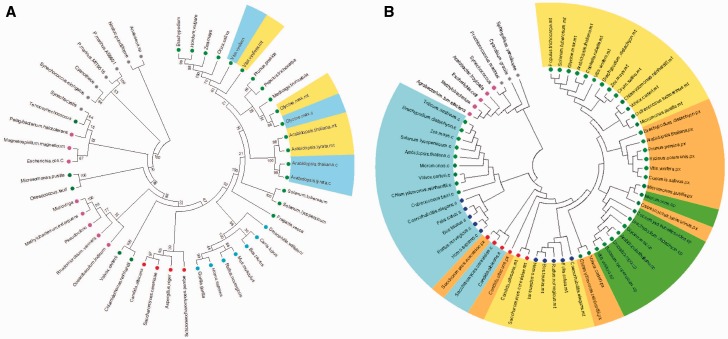
The phylogenetic tree of (A) fumarase and (B) MDH. Trees were built using putative amino acids sequences from (A) fumarase and (B) MDH. Subcellular compartments are highlighted as in figure 2: Mitochondrial isoforms are highlighted by yellow background, peroxissomal isoforms by orange background, and cytosolic isoforms by blue background. Sequences of putative proteins from plants are highlighted by green circle, yeast by red circle, animals by blue circle, algae by dark green circle, bacteria by pink circle, and cyanobacteria by gray circle.